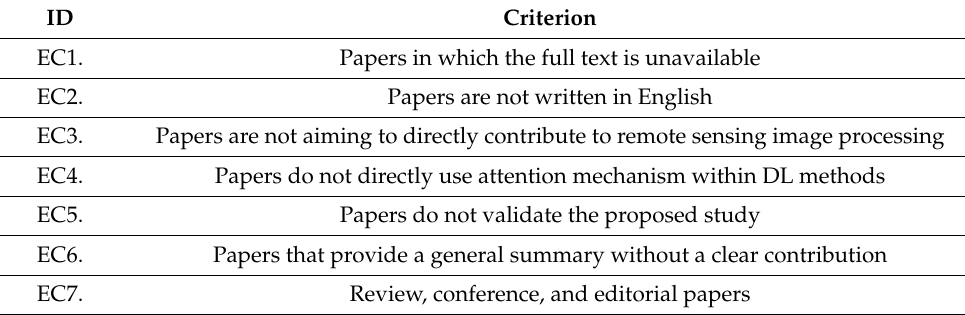
Table 1. Exclusion